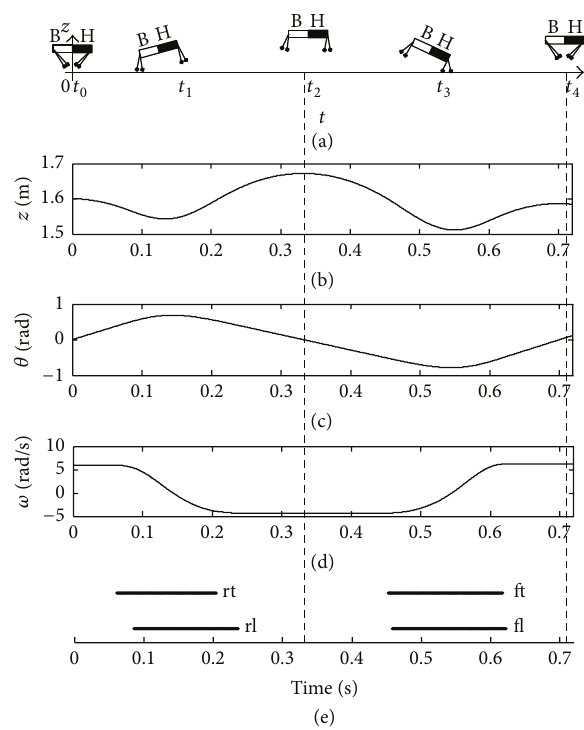
Figure 12: Balance posture of the quadruped robot with